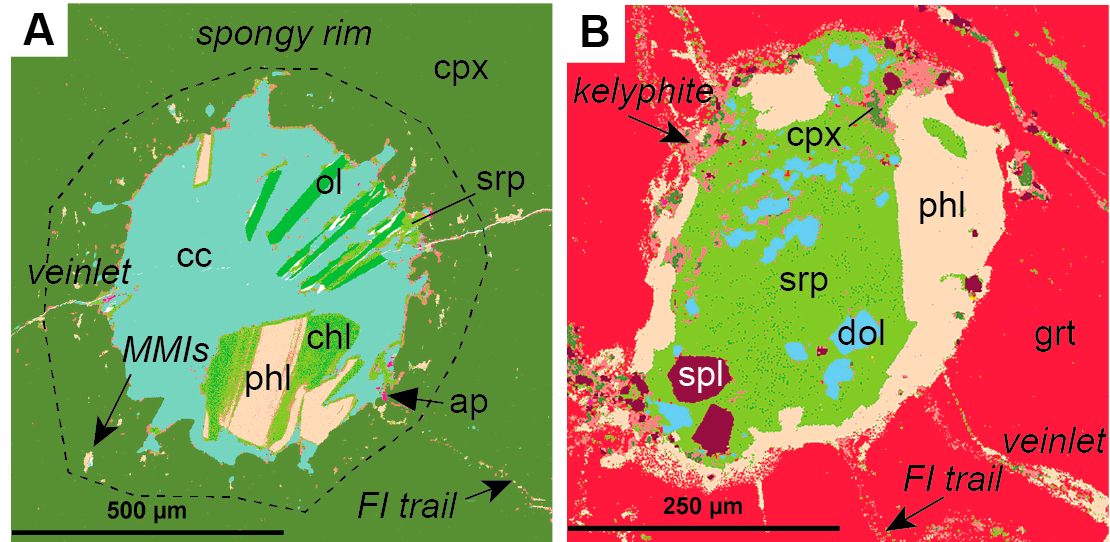
Figure 2. False-colored QEMSCAN ® (Quantitative Evaluation of Minerals by Scanning Electron Microscopy) images of typical polymineralic inclusions (modified after Bussweiler et al. [44]; their Supplementary Figure 1 ( A ) Polymineralic inclusion within a Cr-diopside megacryst (cpx) surrounded by a spongy rim, micro-melt inclusions (MMIs), fluid inclusion (FI) trails, and veinlets. Typical inclusion phases are calcite (cc), olivine (ol), serpentine (srp), phlogopite (phl), chlorite (chl), and accessory apatite (ap); ( B ) Polymineralic inclusion within a Cr-pyrope megacryst (grt) surrounded by a kelyphite rim, fluid inclusion trails, and veinlets. Typical inclusion phases in addition to those observed in ( A ) are dolomite (dol), spinel (spl), and clinopyroxene